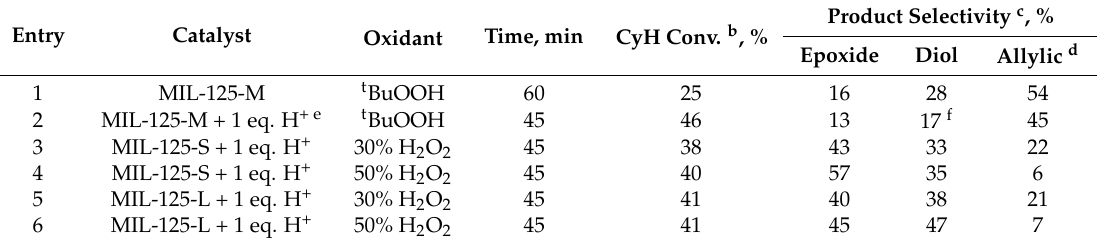
Table 3. The effect of the nature of an oxidant on CyH oxidation over MIL-125 a